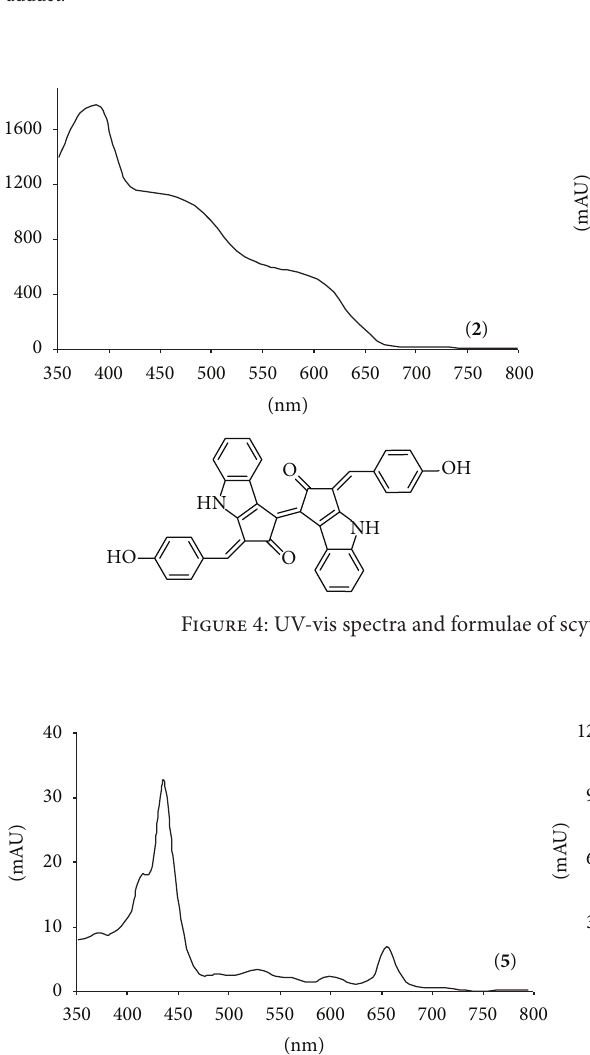
Figure 5: UV-vis spectra of phaeophytin a ( 5 ) and phaeophytin b ( 7